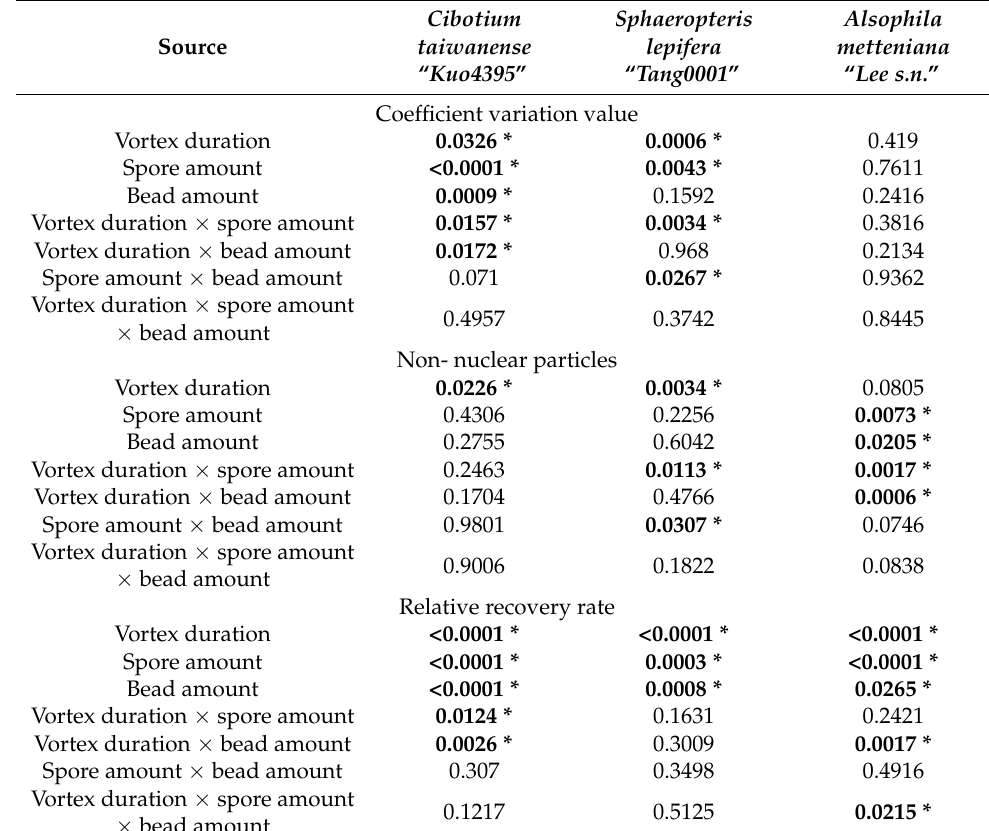
Figure 1. Estimation of ( A ) Cibotium taiwanense “ Kuo4395 ”, ( B ) Sphaeropteris lepifera “ Tang0001 ”, and ( C ) Alsophila metteniana “ Lee s.n. ” spore genome sizes by flow cytometry using the internal standards of leaf nuclei of Pisum sativum cv. Ctirad and Nicotiana tabacum cv. Xanthi. Table 2. ANOVA statistics of cytometric performance using different bead vortex conditions of the three spore collections. * p -value < 0.05.